Question: Author a descriptive caption for the visualization shown.
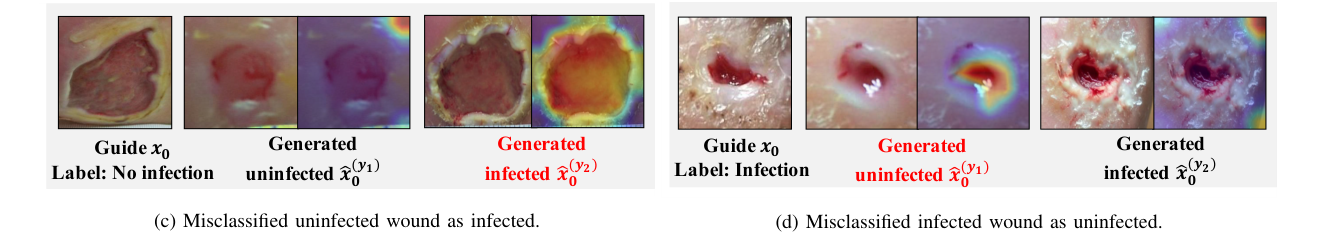
Answer: Visualization of ConDiff predictions with corresponding Score-CAM images computed from the ConDiff’s embedding model fφ. Each sub-figure shows an example with the guide image (x0), conditional synthesized images representing uninfected ˆx(y1) 0 and infected ˆx(y2) 0 states, and their respective Score-CAM overlays indicate regions with similar features to x0.